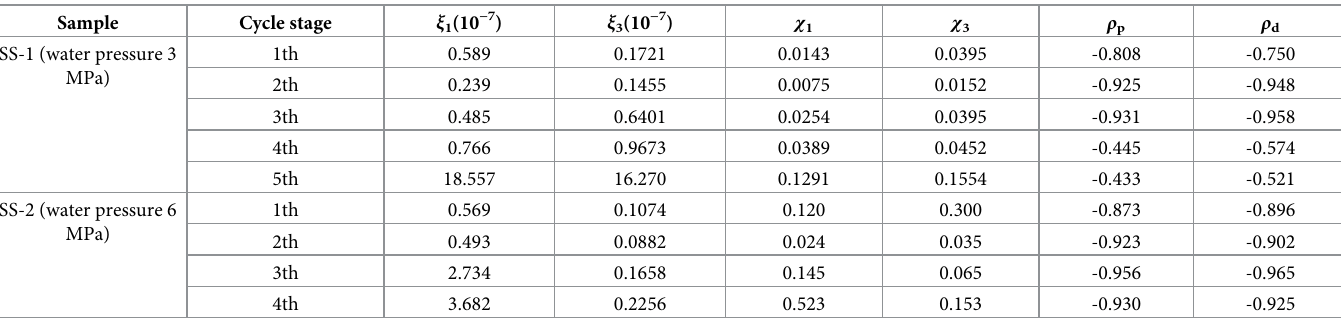
Table 2. Basic experimental data from sandstone sample.